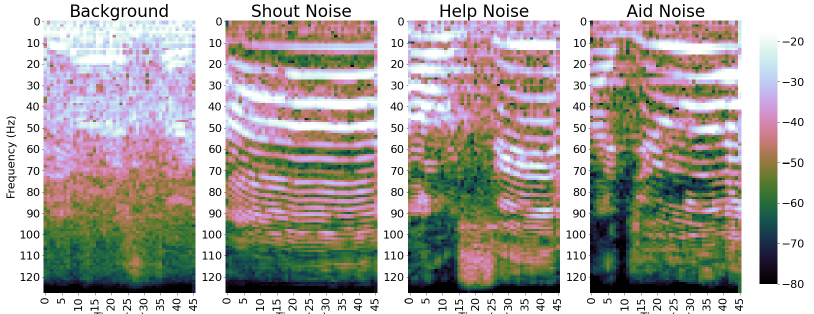
Figure 3. Mel spectrogram in a window of 45 cs for each category. Horizontal axis corresponds to time and vertical axis corresponds to frequency. Darker colors indicate lower magnitude values.